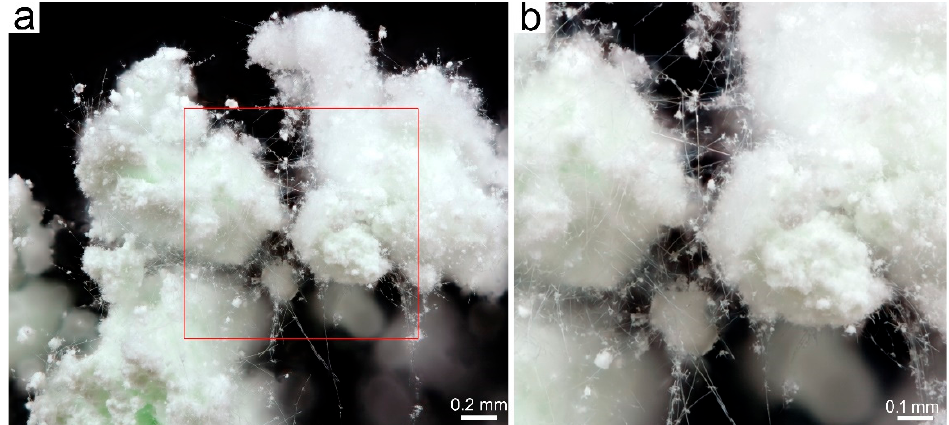
Figure 4. ( a ) Stereoscopic binocular microscope image of white fibers of Ni-doped tremolite run TN8; ( b ) enlargement of the red square of Figure ( a ).